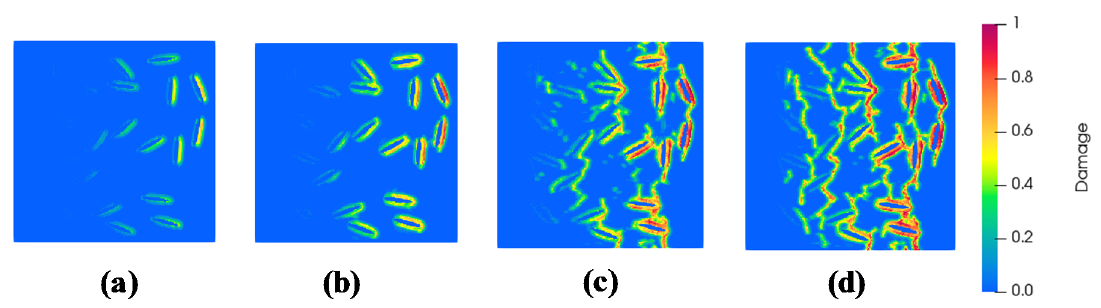
Figure 5. Progressive damage observed in iron powder (10%) modified HCP corresponding to applied tensile strains of ( a ) 24 µε , ( b ) 78 µε , ( c ) 121 µε and ( d ) 130 µε .